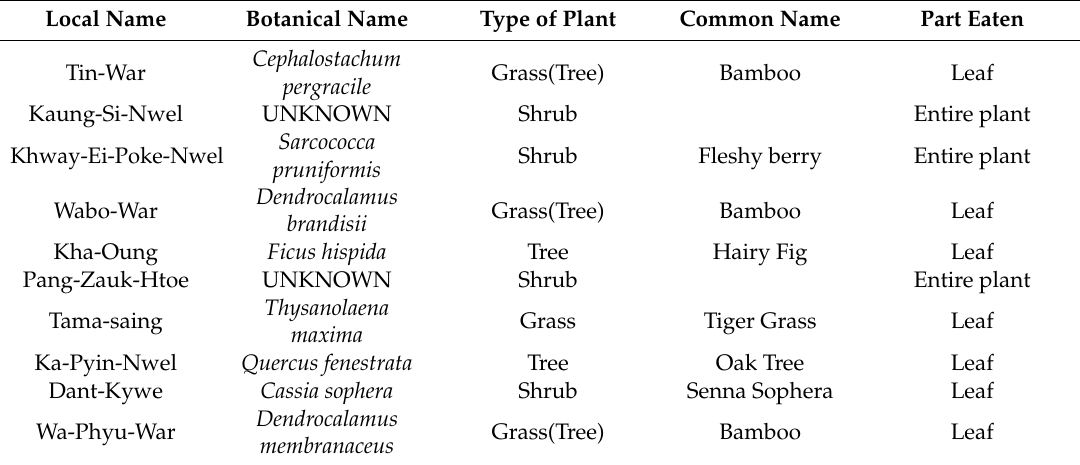
Table 2. Preferred plants eaten by Asian elephants ( Elephas maximus ) at Nat-pauk maternity camp near Katha, Myanmar. Local Name Botanical Name Type of Plant Common Name Tin-War